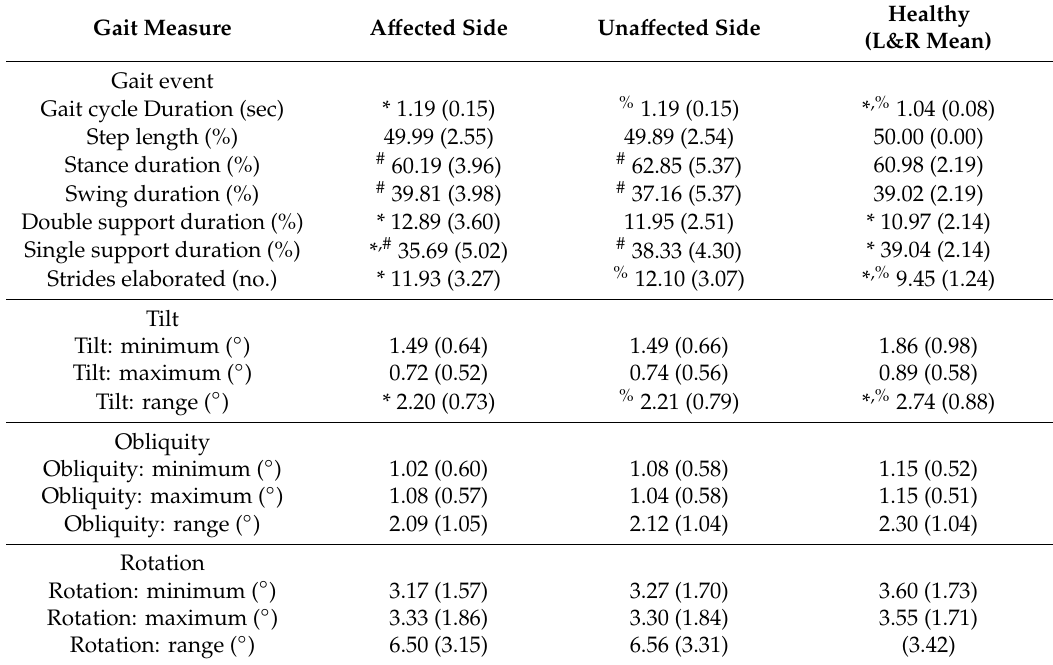
Table 2. Gait variables of hemiplegic stroke patient’s a ff ected / una ff ected side and healthy control.